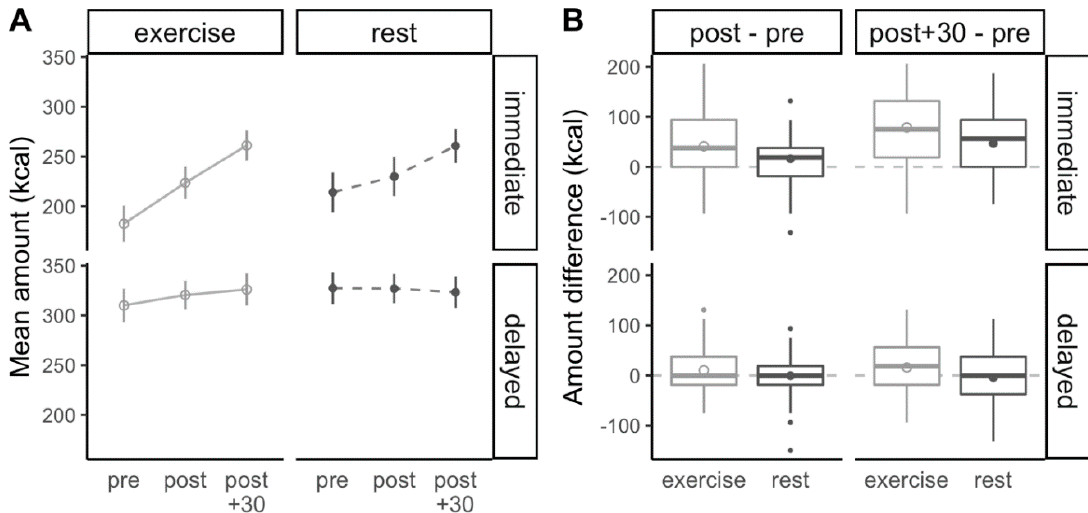
Figure 3. ( A ) Food amount preferences for immediate and delayed consumption at each time point during the experiment. ( B ) Changes in food amount preference from before to immediately after the exercise/rest bout (post - pre) and from before to 30 min after completion of the exercise/rest bout (post+30 - pre) for immediate and delayed consumption for condition interactions (exercise vs. rest). Positive values indicate an increase in the food amount preferences after the exercise or rest condition, and negative values represent a reduction in food amount preferences. Circles represent means and error bars represent 95% within-subject confidence intervals, horizontal bars represent medians, boxes represent interquartile ranges, whiskers represent observations within 1.5 times the interquartile range, and outer points represent outliers.